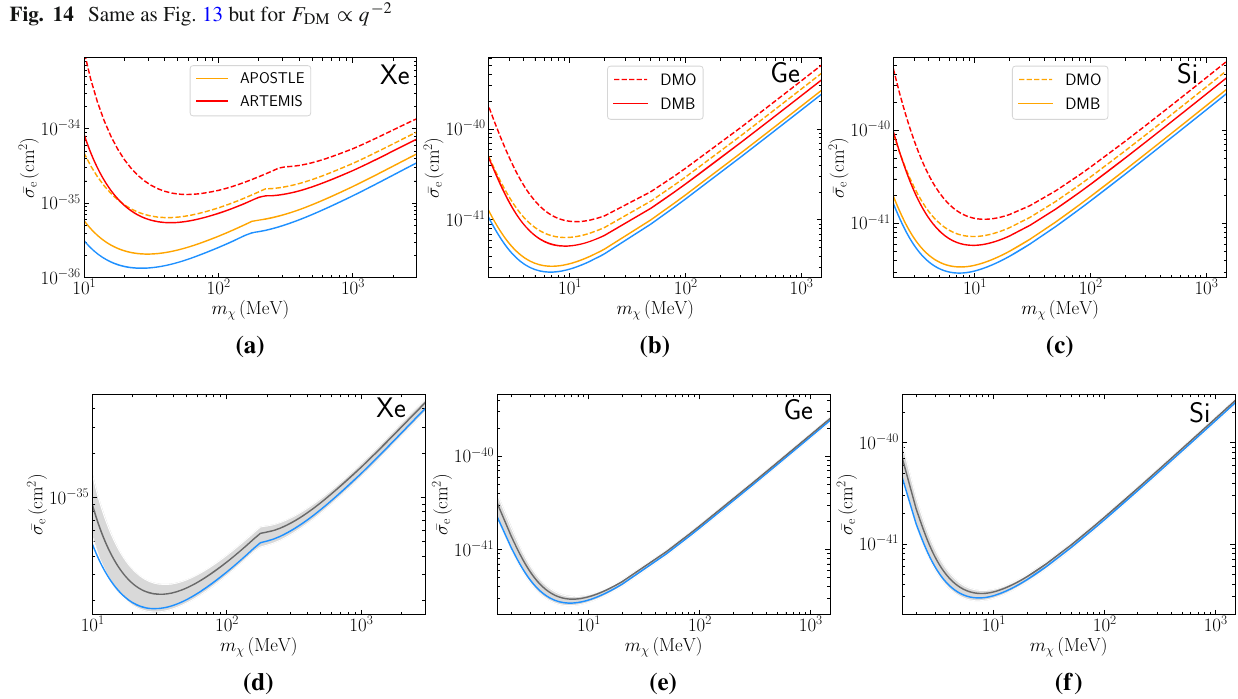
Fig. 15 Shifts in the exclusion limits for Mao et al. distribution with F DM ∝ q − 1 . In the upper panel we show the variations for the best fit values of different cosmological simulations. The bands in the lower